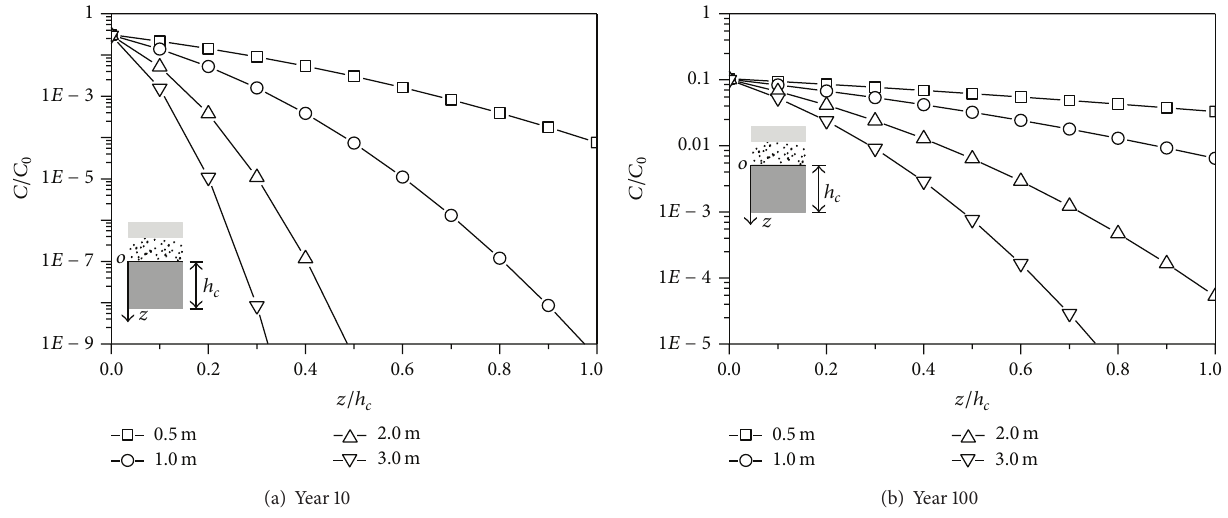
Figure 8: Comparison of numerical results with different CCL thicknesses.